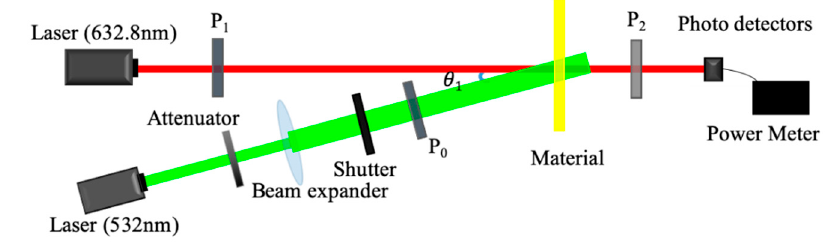
Figure 6. Diagram of photoinduced birefringence measurement device: θ = 6°, P 0 , P 1 , and P 2 are ◦ polarizers and positive 45 ◦ polarizers, horizontal polarizers, negative 45° polarizers and positive 45° polarizers, respectively. horizontal polarizers, negative 45